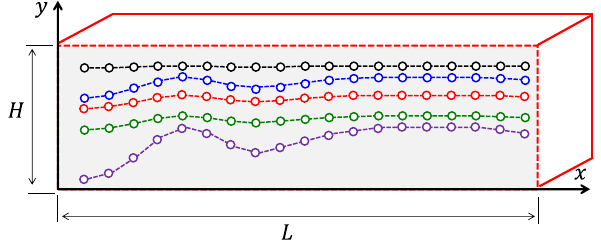
Fig. 4. Example of curves obtained by varying the parameters set a and